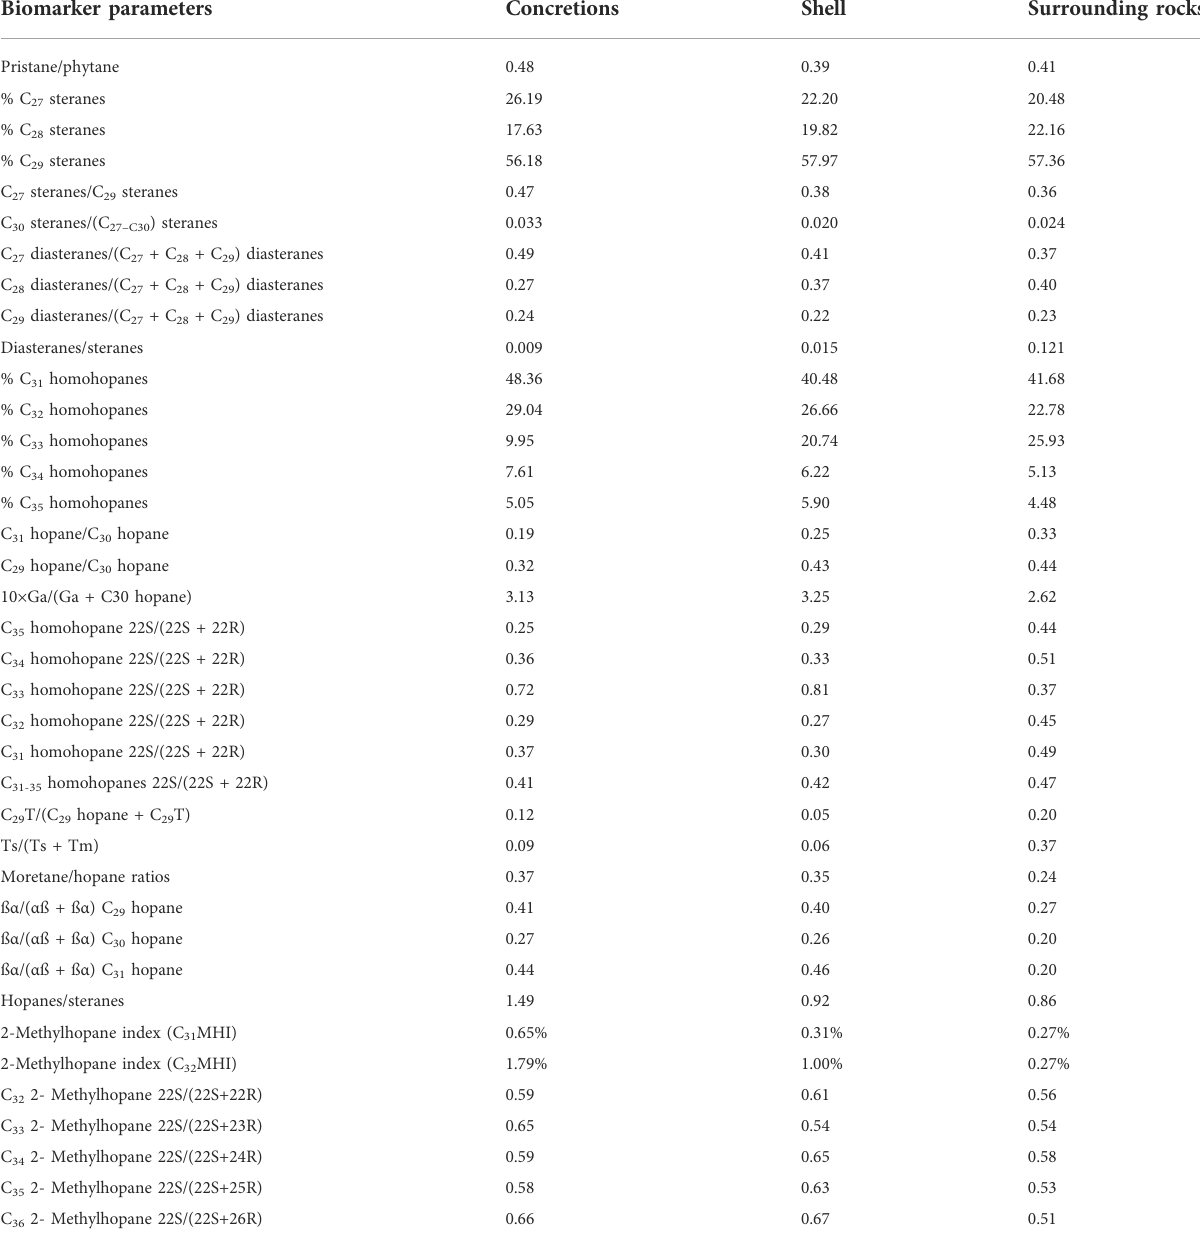
TABLE 2 Biomarker ratios for the concretions and host